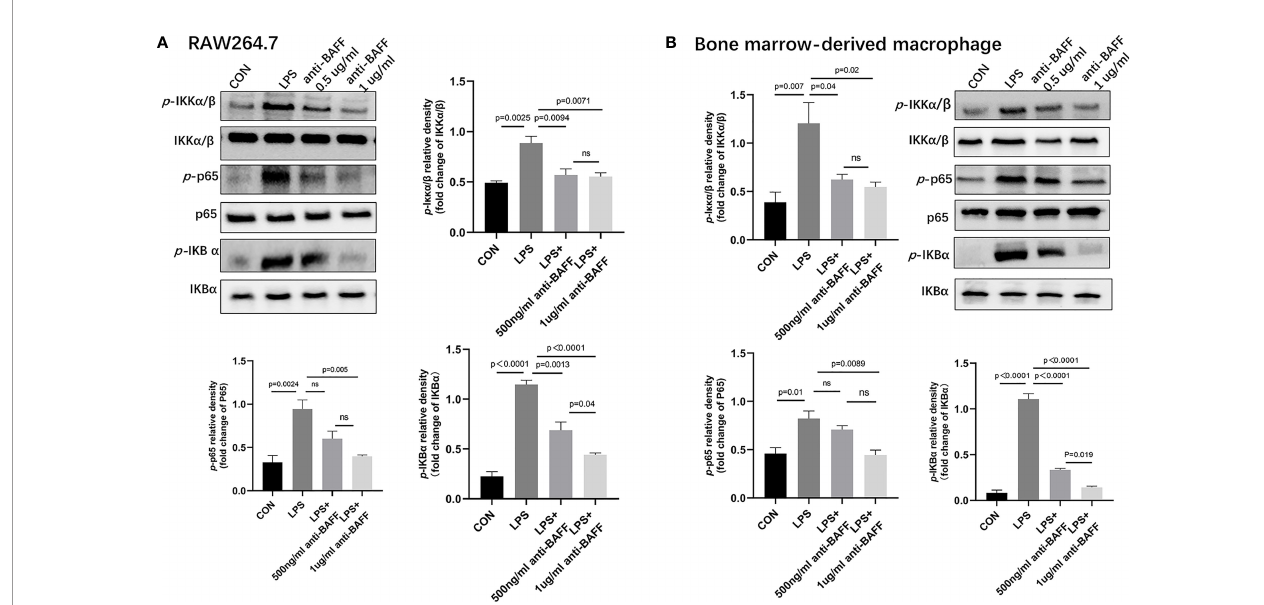
FIGURE 9 | Anti-BAFF antibody inhibited NF- k B signaling pathways in RAW264.7 cells and bone derived macrophages (BMDMs). RAW264.7 cells and BMDMs were primed with LPS (1 ug/ml) for 6 h, then BMDMs pulsed with ATP (2 mM, Sigma-Aldrich, MO, USA) for 30 min. Anti-BAFF antibody or mouse immunoglobulin